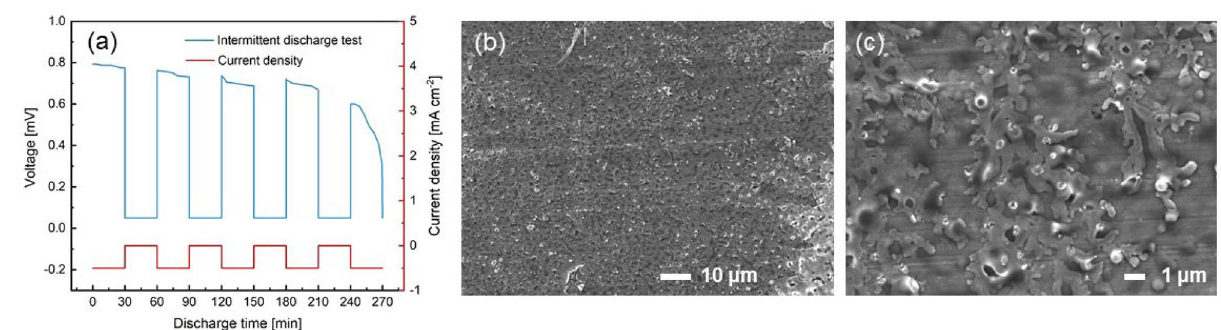
Figure 6. ( a ) The intermittent discharge profiles of the Al–air battery at 0.5 mA cm −2 . ( b , c ) The morphology of the aluminum surface after